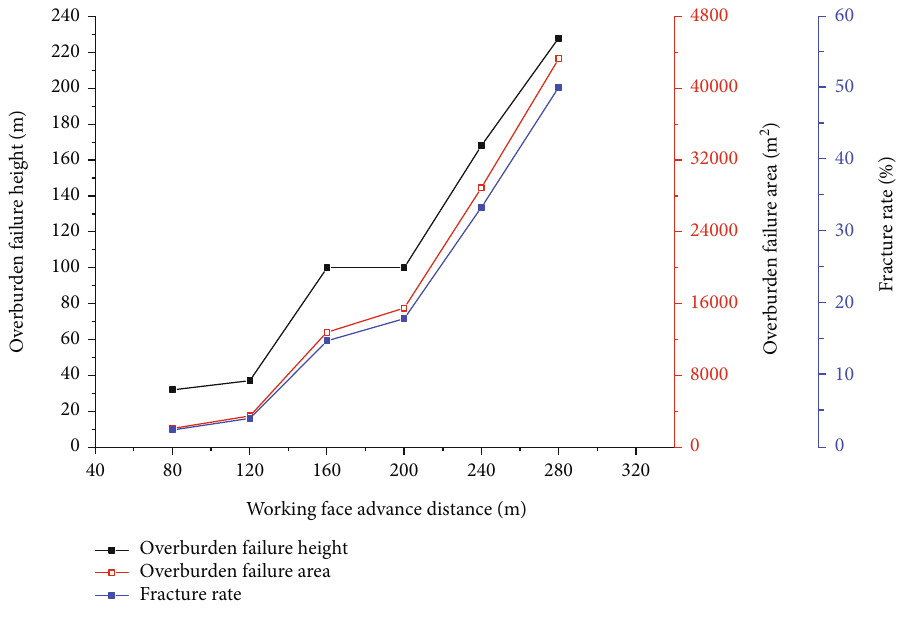
Figure 11: Overburden migration failure fracture evolution curve. Table 3: The width and height of overburden